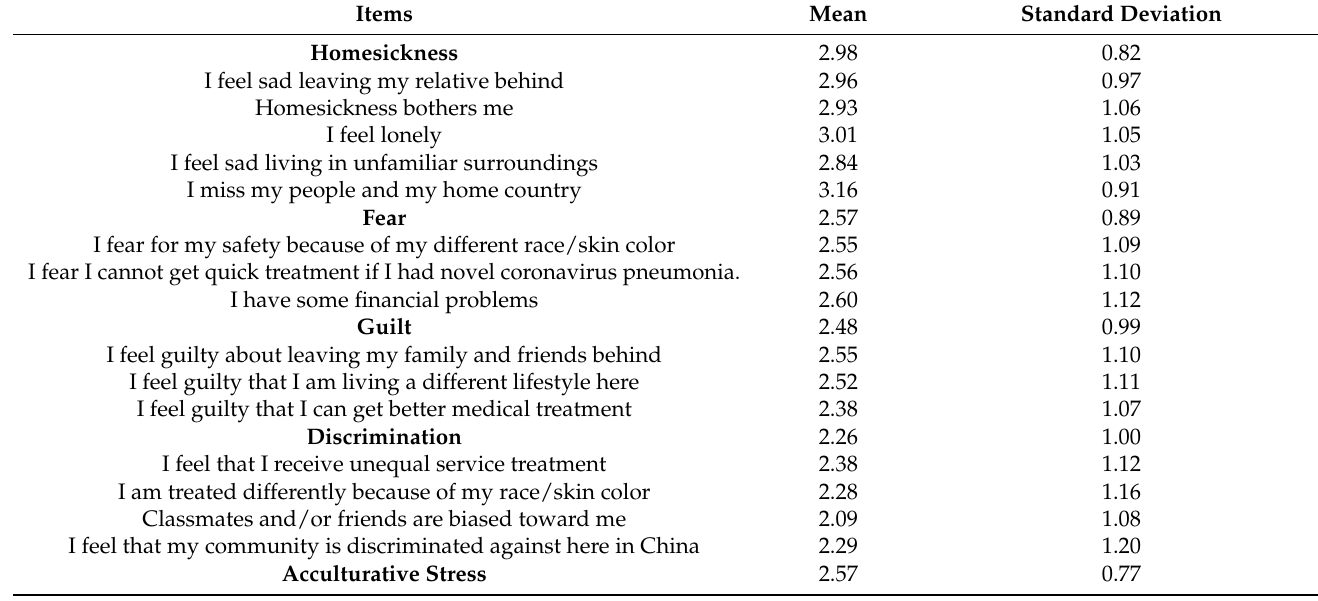
Table 2. Items for acculturative stress with mean and standard deviation.